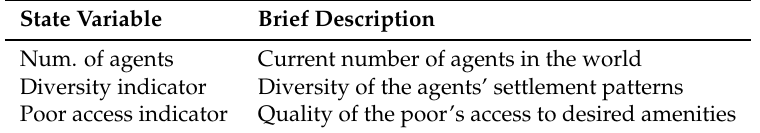
Table 2. State variables and summaries. See accompanying text for a complete description of